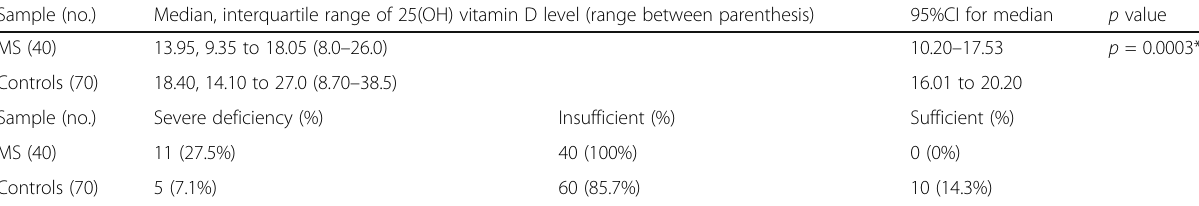
Table 4 Characterization of the 25(OH) vitamin D levels status in the study sample Sample (no.)